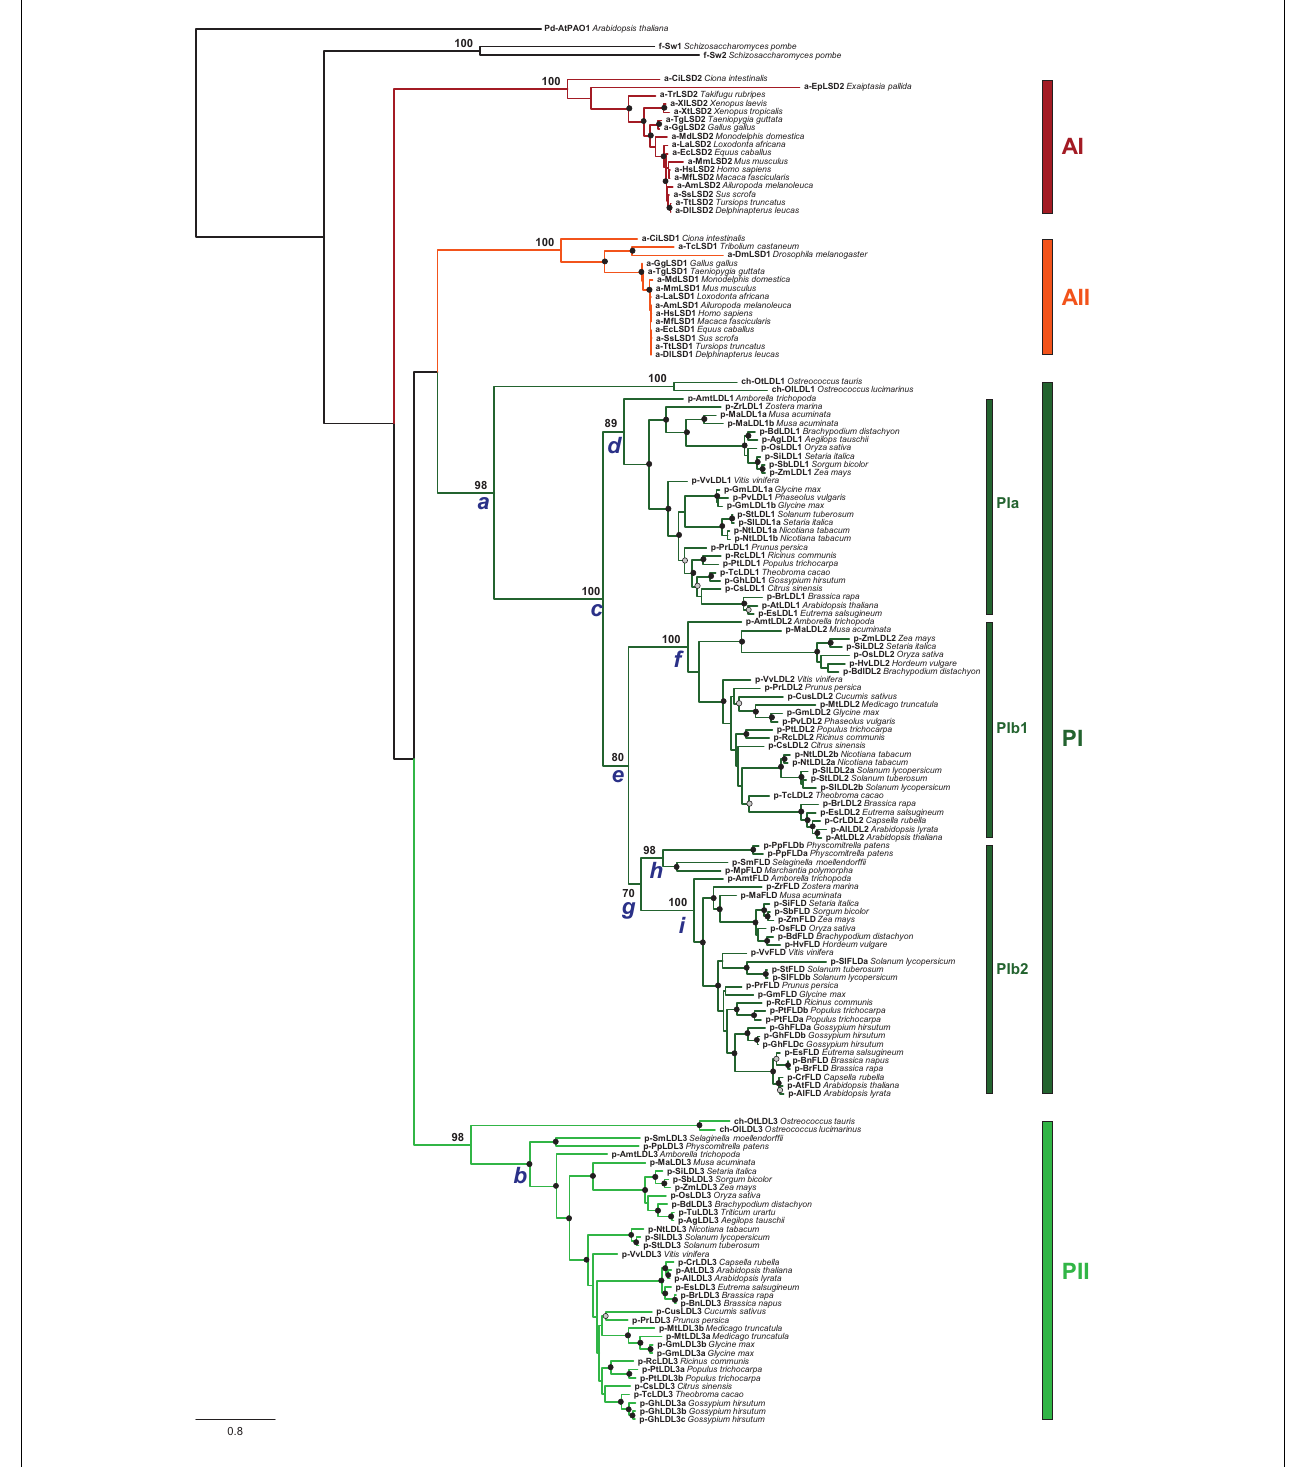
FIGURE 3 | Phylogenetic tree of full-length amino acid sequence of LDL/FLD homologs in representative plant species. Animal HsLSD1 and HsLSD2 homologs, as well as the two Schizosaccharomyces pombe homologs SWIRM1 and SWIRM2 (Nicolas et al., 2006) are also included in this analysis. Phylogenetic analyses were performed with the Maximum Likelihood method using RAXML v.8.2.10 (Stamatakis, 2014) with the PROTGAMMAJTT substitution model. Node support was evaluated with 1,000 rapid bootstrap inferences. The sequence of the polyamine oxidase 1 of A. thaliana (AtPAO1; At5g13700; Supplementary Table 1 ) was used as